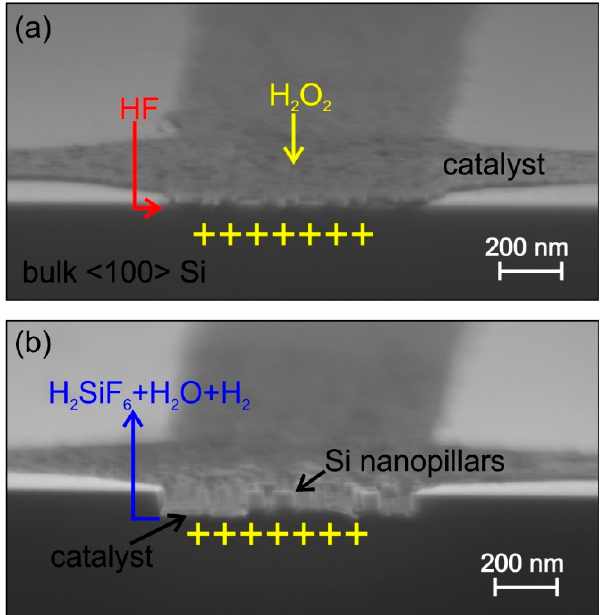
Figure 1. MacEtch mechanism in solution of HF and H 2 O 2 . ( a ) The metal catalyst deposited on a Si < 100 > substrate decomposes H 2 O 2 with consequent injection of holes ( + ) into the semiconductor. ( b ) Si consumes the positive carriers Si, it is readily oxidized by HF and forms silicon fluoride, the process continues and the catalyst progressively sinks into Si along the < 100 > direction, transferring the nanostructure pattern to the Si (formation of nanopillars in this case). Images are cross-section Scanning Electron Microscopy (SEM) of nano-patterned Pt on Si ( a ) after few seconds of MacEtch in solution of HF and H 2 O 2 .